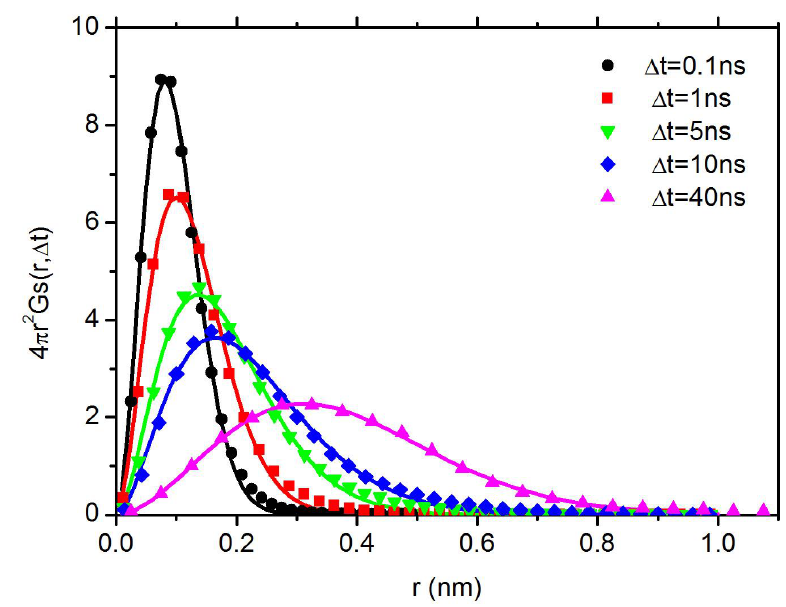
Figure 7. The DDF, 4 π r 2 G s ( r , ∆ t ) , for C 60 in PS melt in the subdiffusive regime (symbols). The solid lines represent the corresponding Gaussian-fitting.